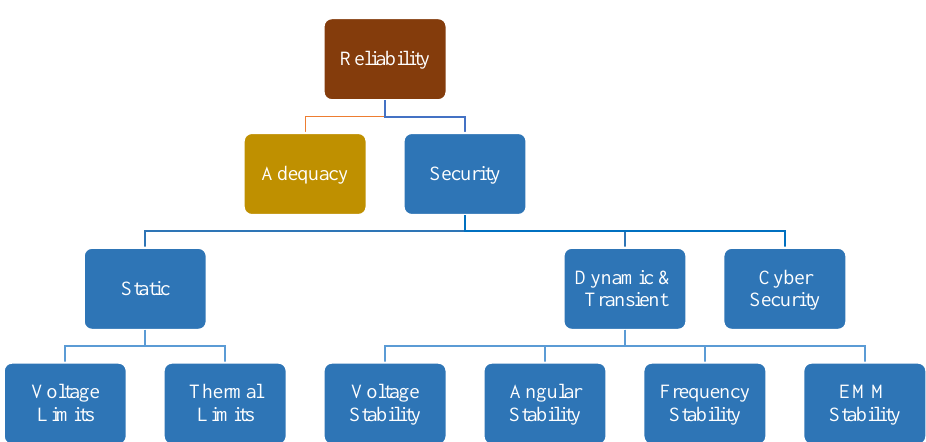
Figure 2. Power system security assessment categories, including both static and dynamic